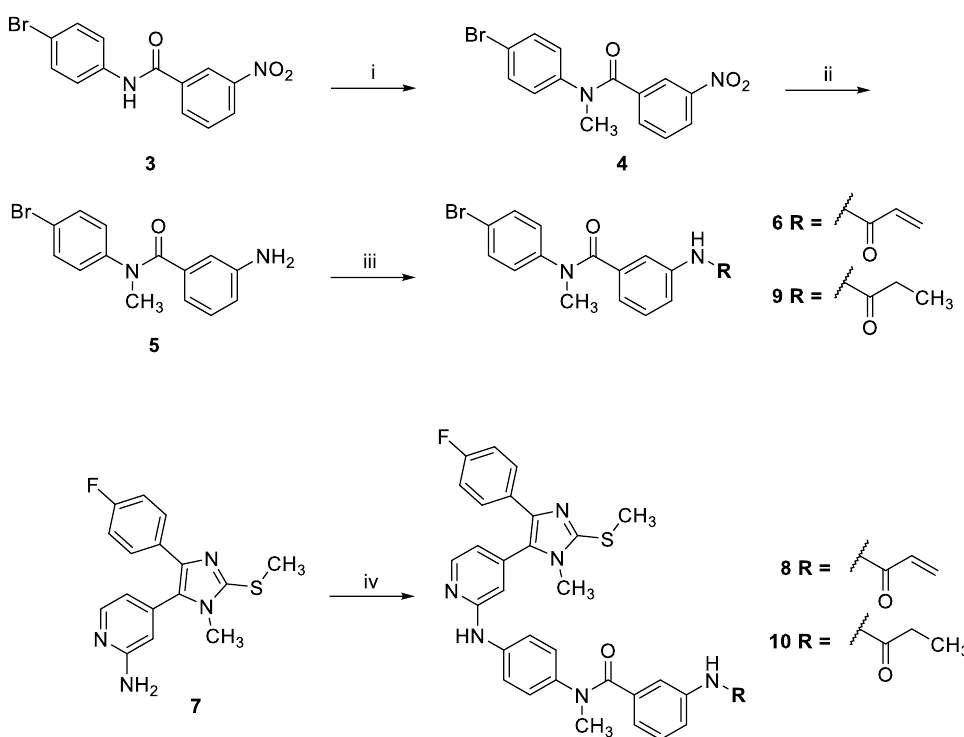
Scheme 1. Synthesis of N -methyl derivatives 8 and 10 . (i) Methyl iodide, NaH, THF, Ar, r.t., 6 h, 88%; (ii) Sn(II)Cl 2 , EtOH, reflux, 16 h, 58%; (iii) acryloyl chloride in the case of 6 or propionic anhy- dride in the case of 9 , DIPEA, 1,4-dioxane, Ar, r.t., 2-3 h, 44%; (iv) 6 in the case of the synthesis of 8 or 9 in the case of the synthesis of 10 , BrettPhos Pd precatalyst, Cs 2 CO 3 , 1,4-dioxane/ t BuOH, Ar, 115 °C, 16 h, 9 – 20%.